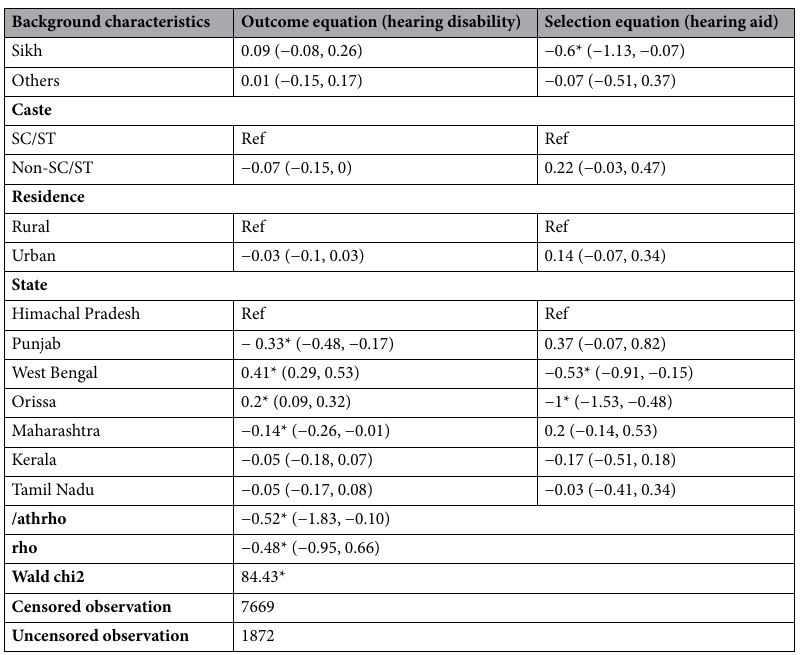
Table 4. Heckprobit model for hearing disability and using hearing aids among older adults in India. Ref: reference, SC/ST: scheduled caste/scheduled tribe. *If p <